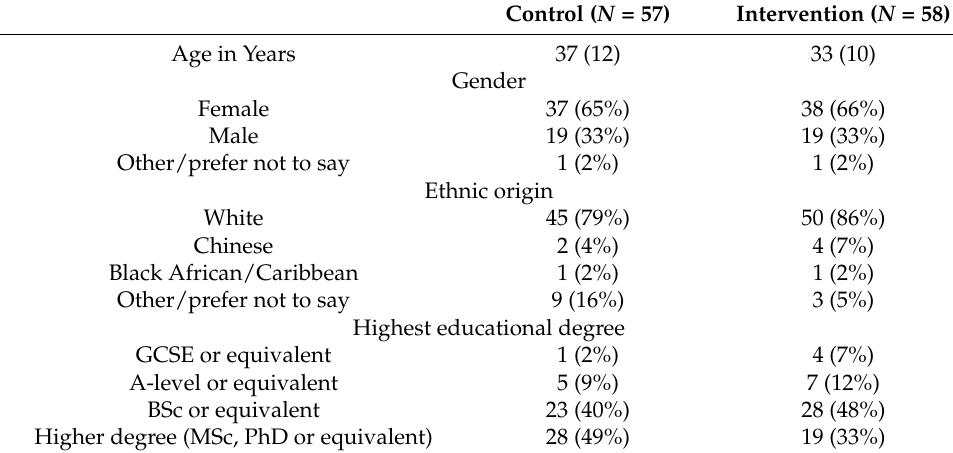
Table 1. Baseline demographic